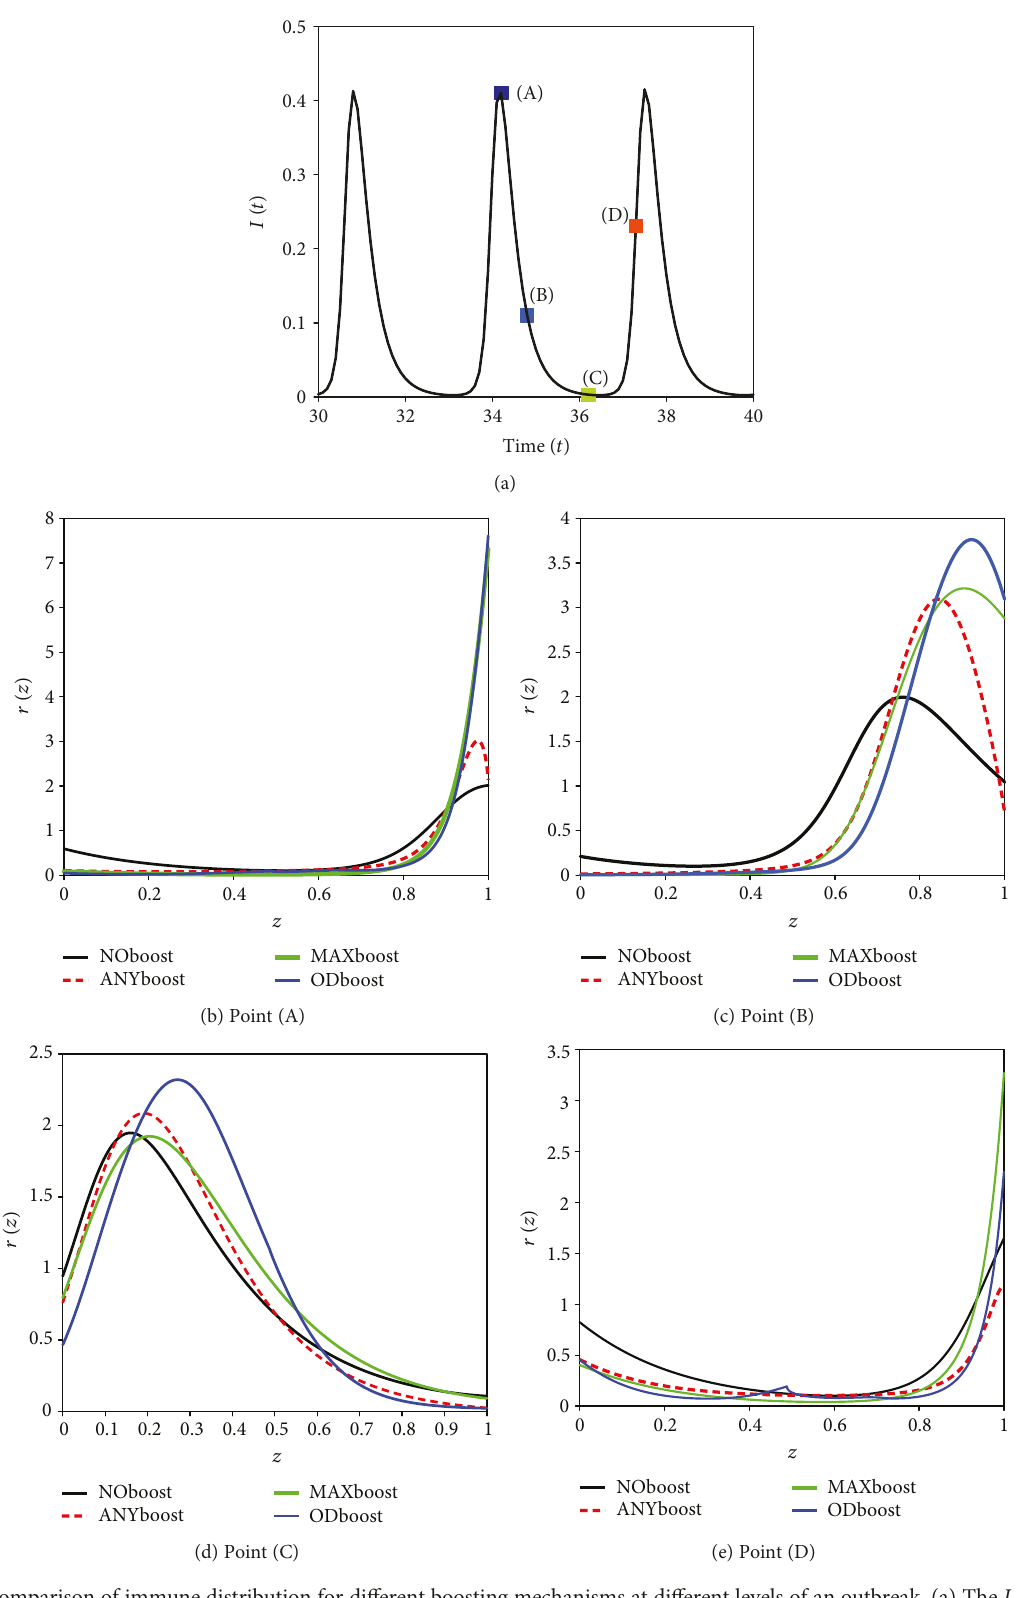
Figure 10: Comparison of immune distribution for di ff erent boosting mechanisms at di ff erent levels of an outbreak. (a) The I solution and the four reference points to be considered for comparison: (A) the infection peak, (B) an intermediate level after the outbreak, (C) the minimal infection level, and (D) just before a new outbreak. (b – e) Immune distribution corresponding to the points (A) –